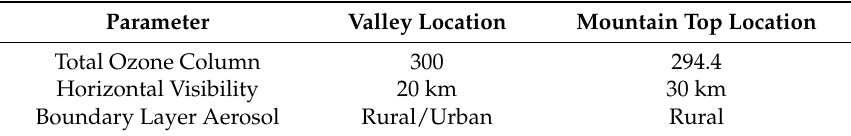
Table 3. Parameter values used in this study.